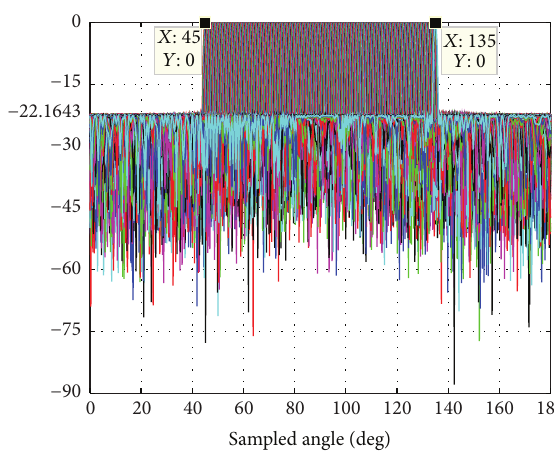
Figure 3: Beam pattern optimized by the proposed algorithm.